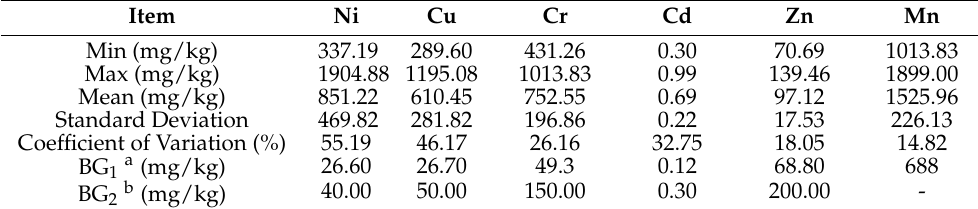
Table 1. Statistical characteristics of heavy metal content in soil ( n = 30).